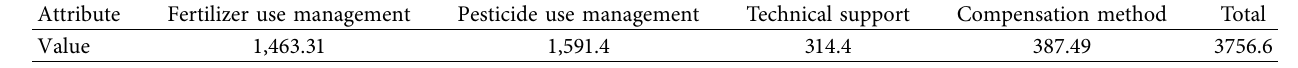
Table 8: Attribute values in the MNL model (unit: yuan/year).